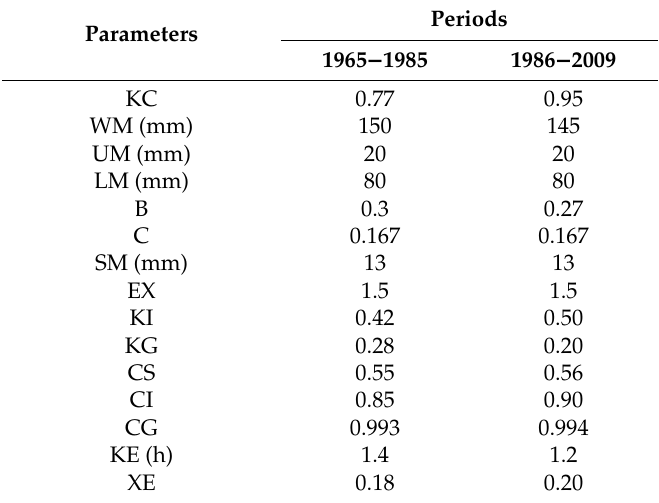
Table 6. Parameters of the two periods before / after land use